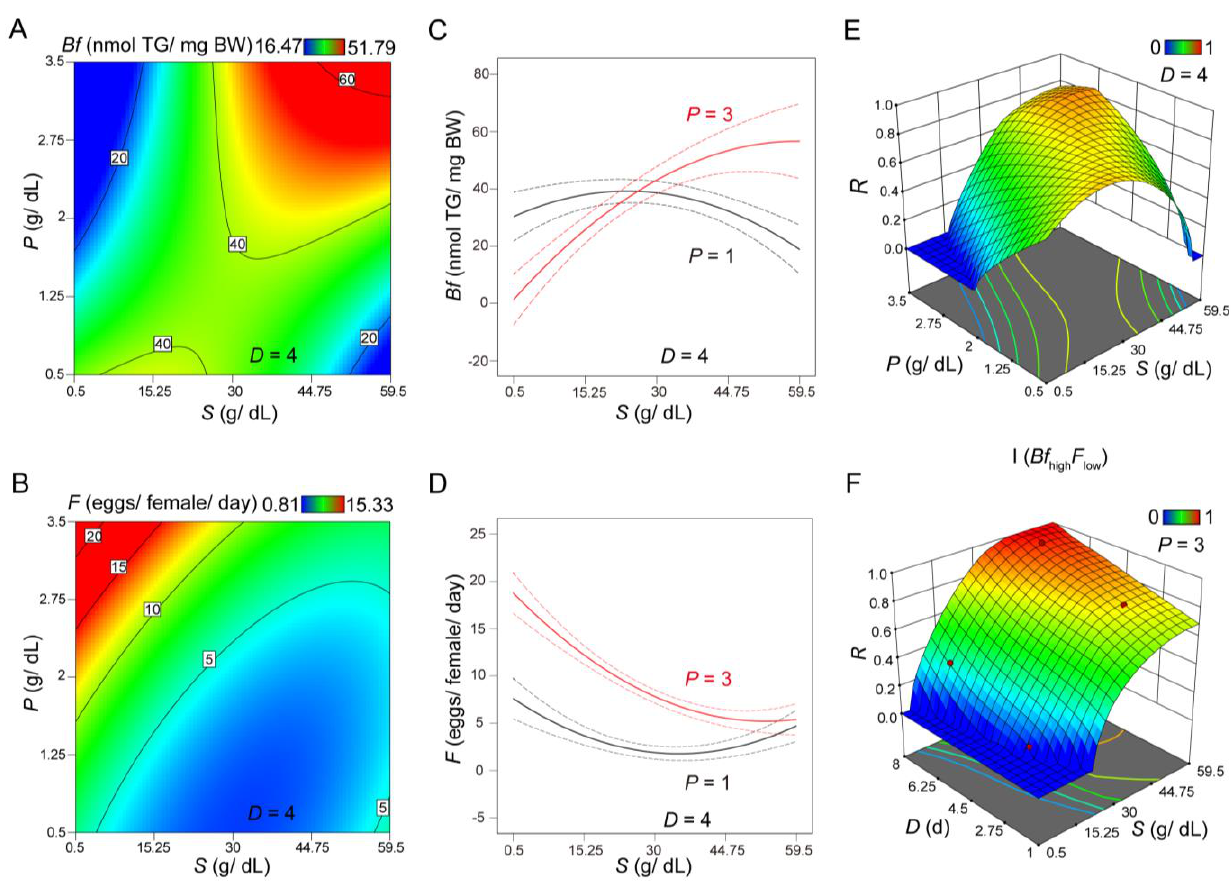
Figure 1. Characterization of Bf and F under various feeding treatment. ( A , B ) Contour plots of Bf ( A ) or F ( B ) at D = 4. The X -axis represents S , Y -axis represents P , and the color represents levels of Bf ( A ) or F ( B ). ( C , D ) Interaction plots of S and P on Bf ( C ) or F ( D ) at D = 4. The X -axis represents S; Y-axis represents Bf ( C ) or F ( D ). The two lines show the response of Bf ( C ) or F ( D ) to S at different levels of P . Dashed lines represent 95% confidence intervals. ( E , F ) Integrated 3D surface plots under Scenario I, showing R as a function of S - P ( E ) or S - D ( F ), respectively. Here, a high value of R represents a high desirability for achieving Bf high F low . D = 4 in panel E and P = 3 in panel F .